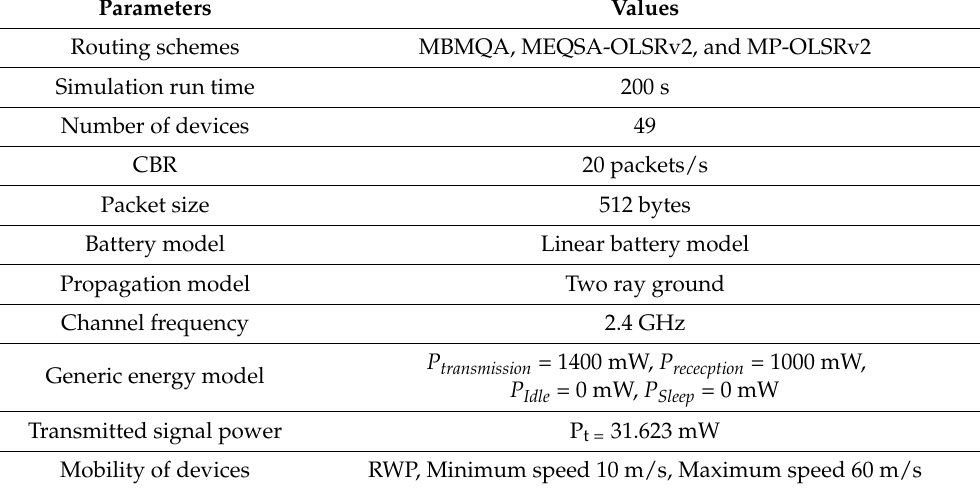
Table 1. Simulation model